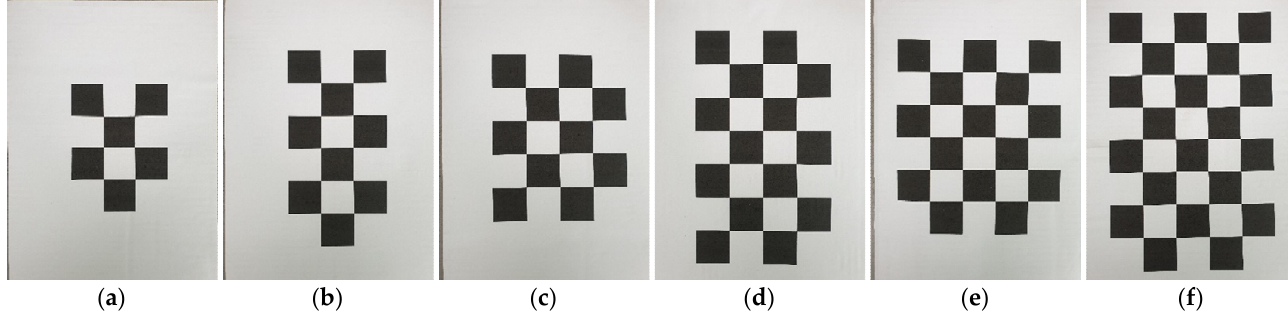
Figure 4. Checkerboards with ( a ) 3 × 4, ( b ) 3 × 6, ( c ) 4 × 5, ( d ) 4 × 7, ( e ) 5 × 6, and ( f ) 5 × 8 squares for the estimation of the intrinsic parameters of the vision sensor.